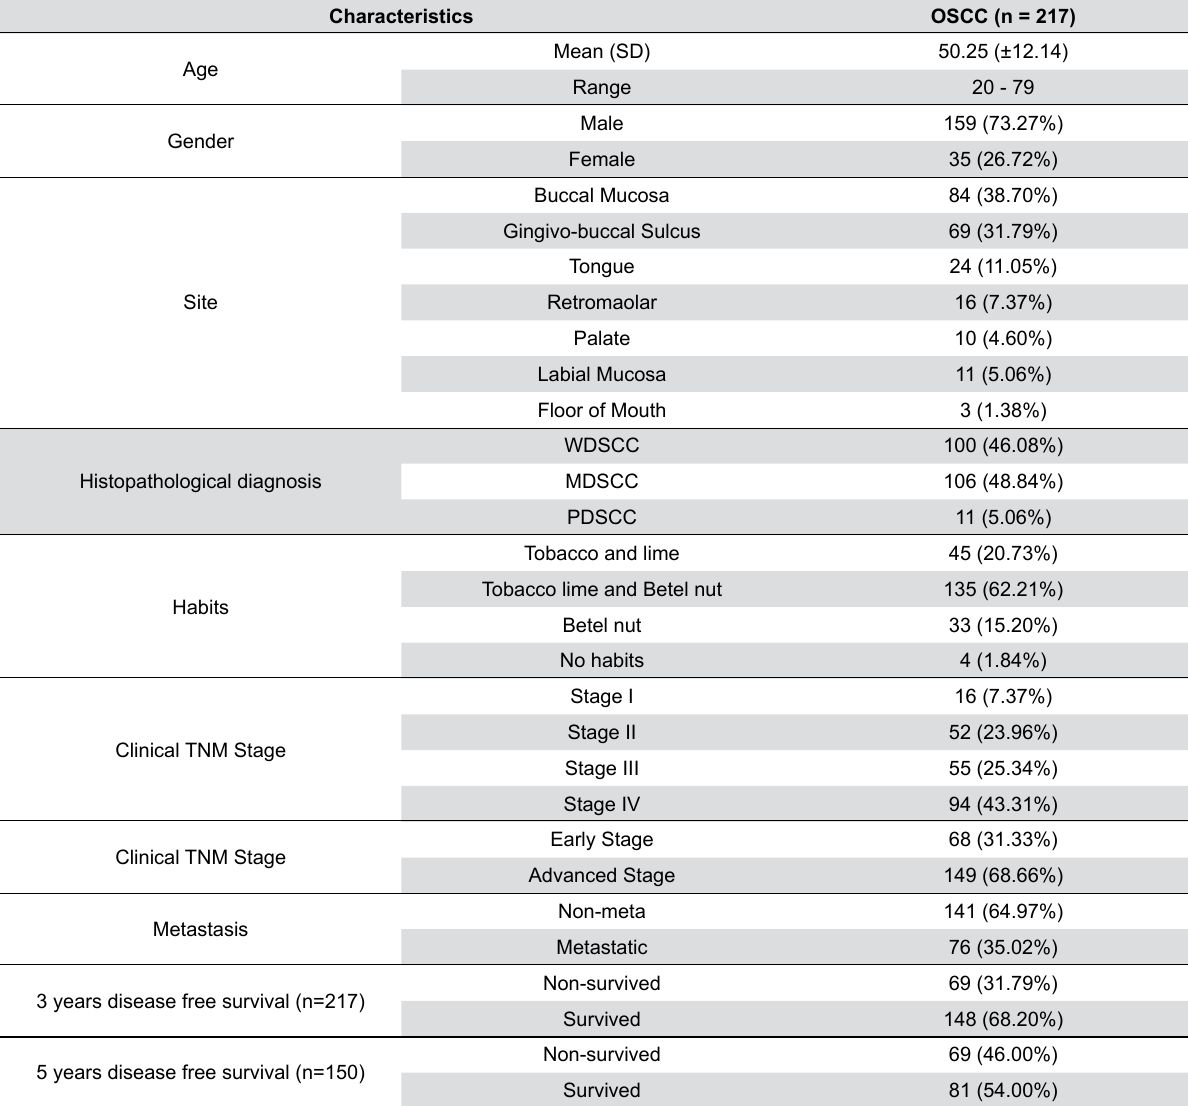
Table 1- Details of demographic and clinicopathological parameters of oral squamous cell carcinoma